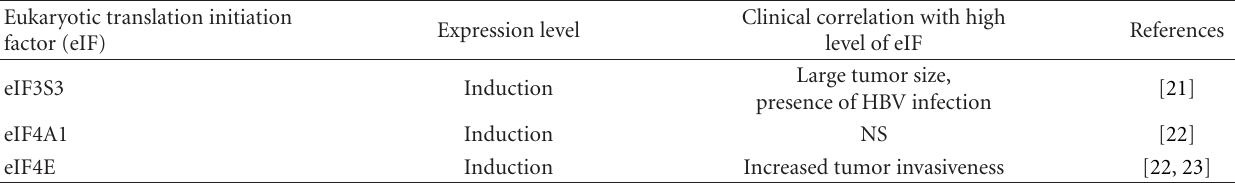
Table 1: Di ff erential expression of di ff erent eIFs in liver